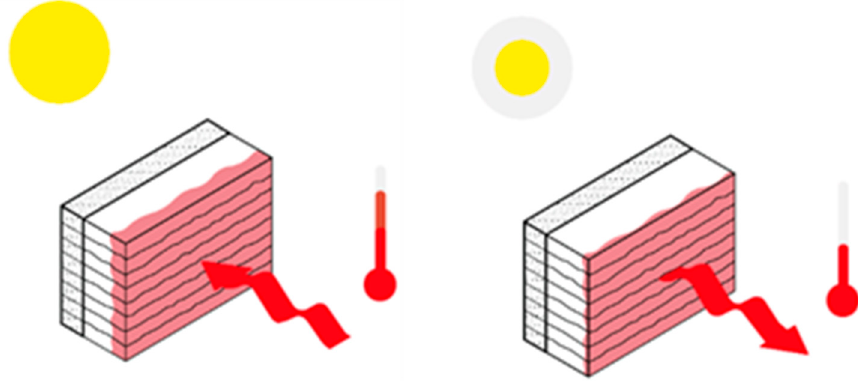
Figure 2. E ff ect of heating and cooling through thermal mass (own representation). Figure 2. Effect of heating and cooling through thermal mass (own